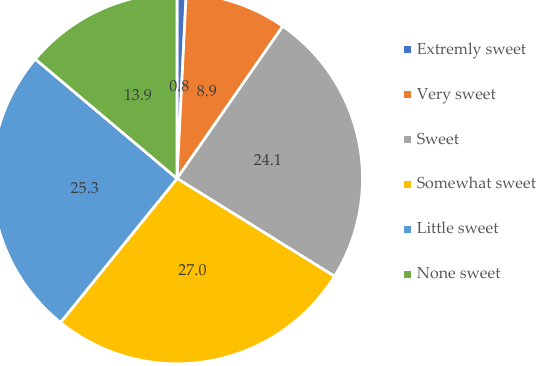
Figure 7. Percentage (%) of sweetness liking of the regular beverage for consumers ( n = 901). The specific factors that consumers consider for the reduced-sugar flavored water were taste (59.4% selection), calories (57.3%) and their health conditions (40.5%), as shown in Figure 8. The results further confirmed the taste or flavor was the most important factor to determine consumption.